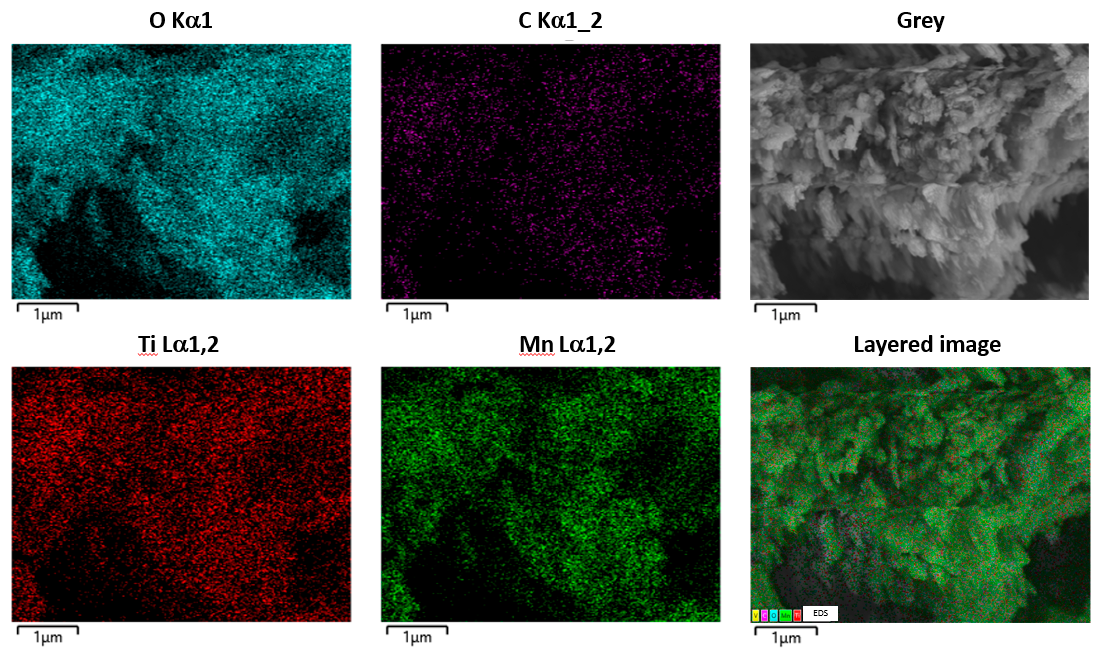
Figure 5. EDS mapping of the Mn-Ti modified zeolite.